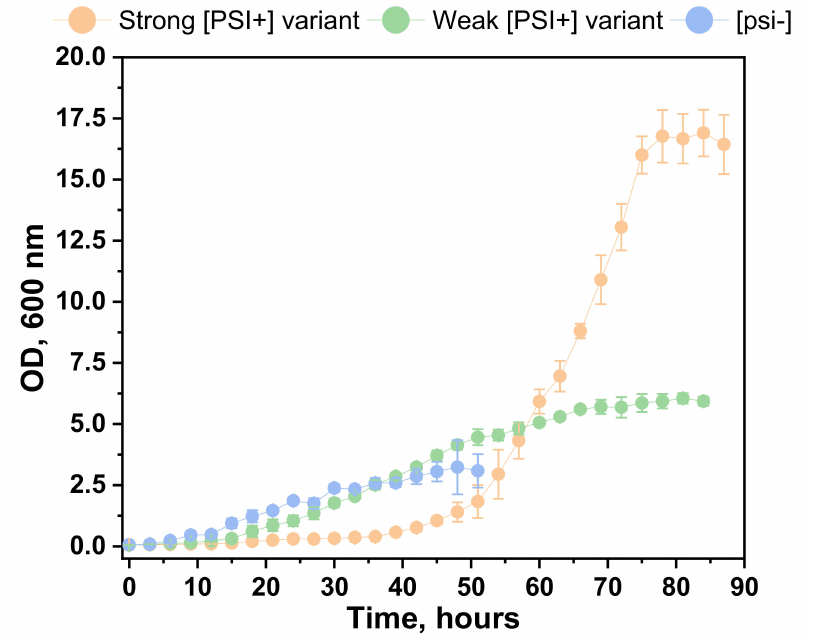
Figure 2. Growth dynamics of S. cerevisiae cells in the SC medium. The orange line represents the growth of S. cerevisiae with a strong [PSI+] variant; the green line represents the growth of S. cerevisiae with a weak [PSI+] variant; the blue line represents growth of S. cerevisiae without [PSI+]. Data presented as average ±